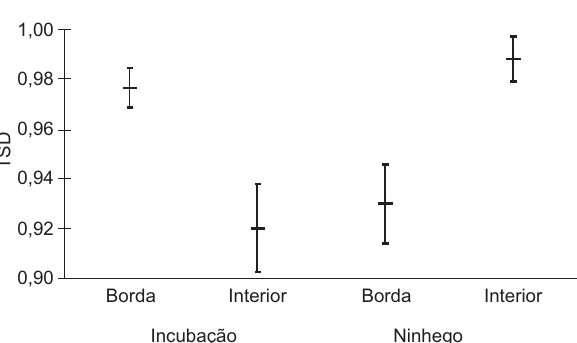
Incubação Ninhego Figura 1. Taxa de sobrevivência diária (TSD) de ninhos naturais de E. chiriquensis na borda e no interior da Estação Ecológica de Águas Emendadas durante a fase de incubação e de ninhego na estação reprodutiva de